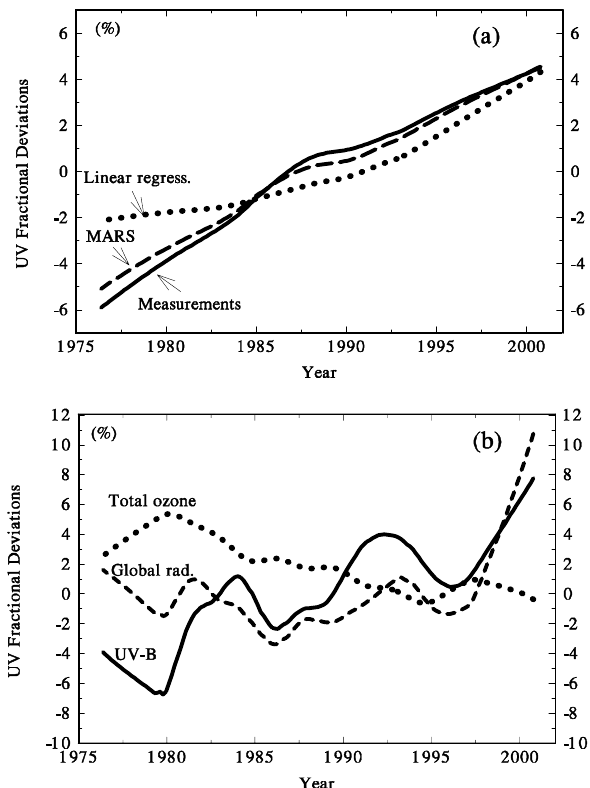
Fig. 4. The observed (solid curve) and modeled decadal variations of the UV fractional deviations for the snowless part of the year in the 1976–2000 period by stepwise regression (Model A – dot- ted curve) and MARS model (Model D – dashed curve) – Fig. 4a. The observed year-to-year variations in the UV fractional devia- tions (solid curve), total ozone (dotted curve), and total solar radia- tion (dashed line) – Fig. 4b. LOWESS smoother is used to extract decadal and year-to-year variations in the analyzed time